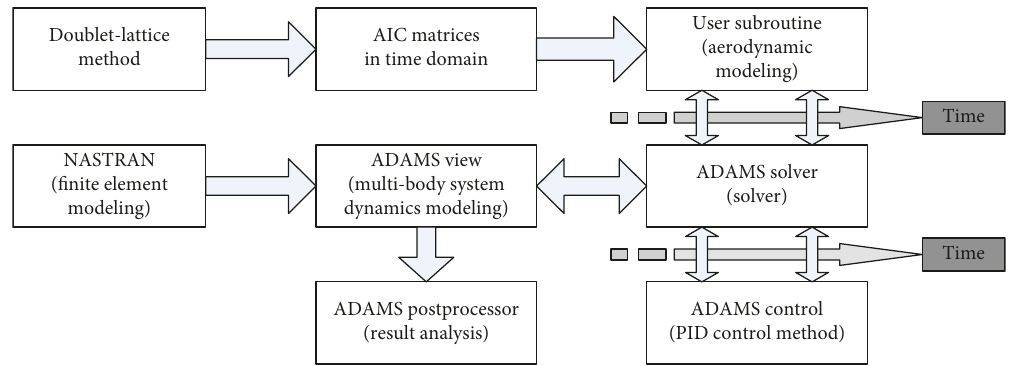
Figure 2: Aeroelastic fl ight simulation